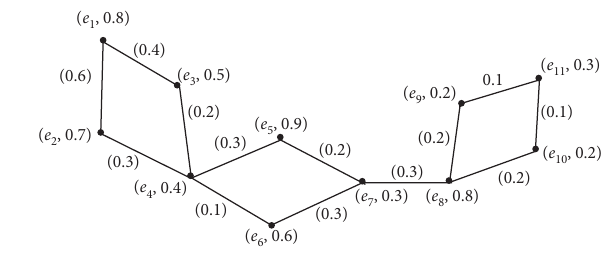
Figure 1: Fuzzy graph G � ( J , K ) .